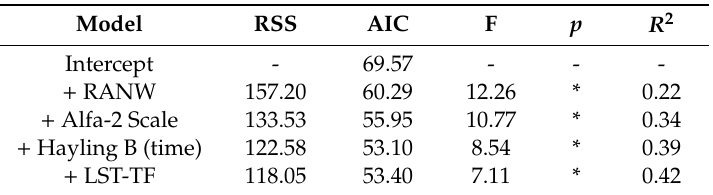
Table 3. Stepwise